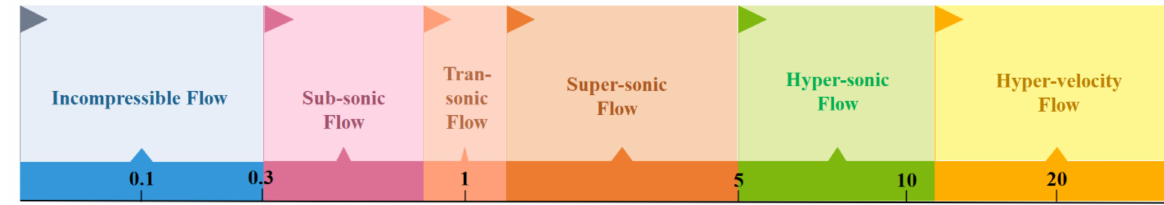
Figure 14. Various flows in different Ma